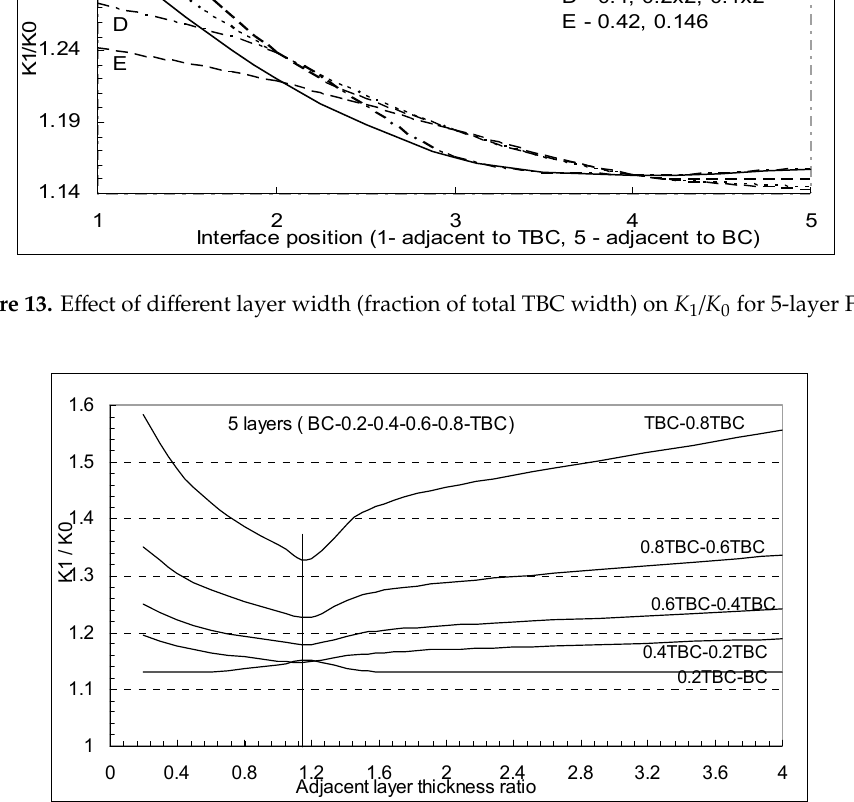
Figure 14. Effect of varying adjacent layer thickness with fixed number of layer (5) and uniform compositional variation.